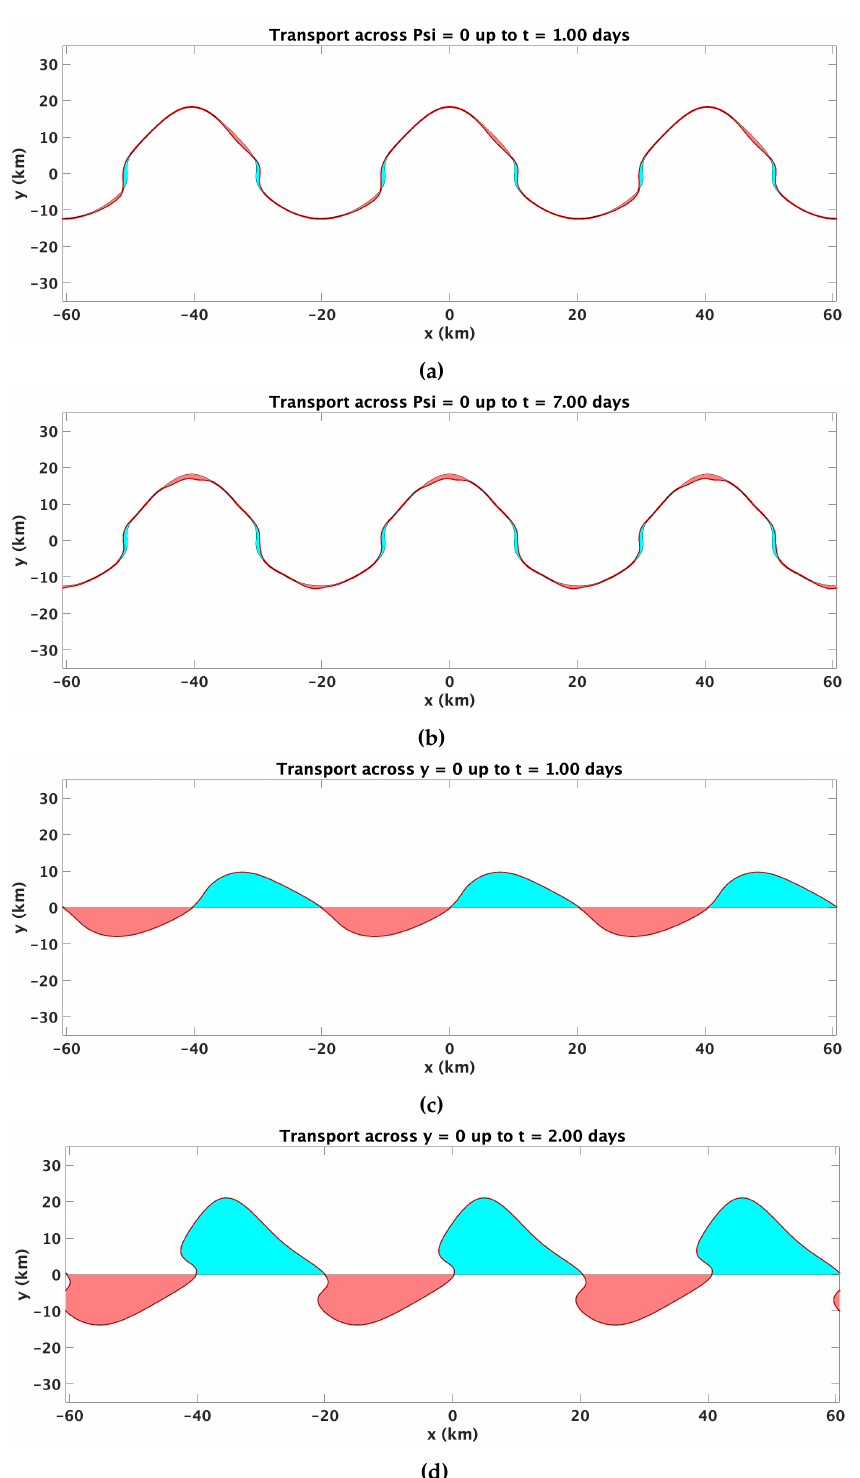
Figure 9. Cross-shelf transport for the case matching observed parameters for ( a ) one tidal period across Ψ = 0, ( b ) one wave period (seven tidal periods) across Ψ = 0, ( c ) one tidal period across y = 0, and ( d ) two tidal periods across y = 0. Red indicates water masses transported on-shore and cyan those moved